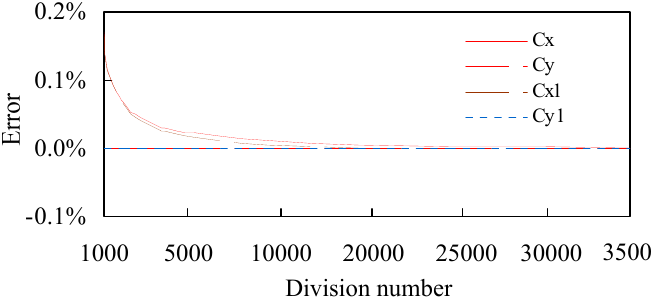
Figure 5. The relation between the four-numerical solution C x , C y , C x 1 , and C y 1 and the subdivision amount m and n . For the corner segment of the coil, the angle is divided into 35,000 parts, the radius is divided into 35,000 parts, and m is equal to n .